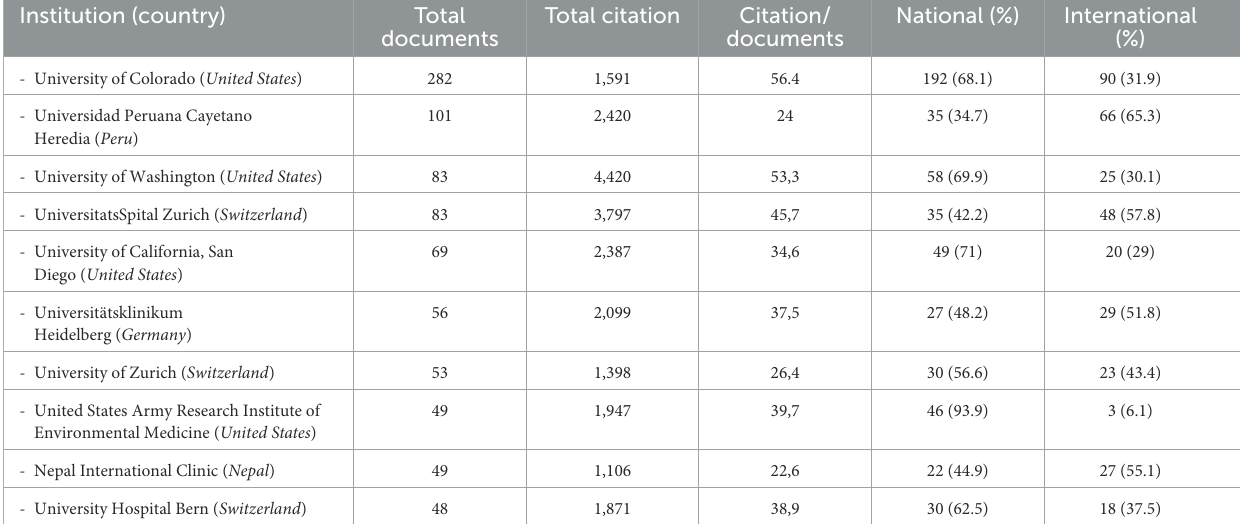
TABLE 3 Top 10 publications and institutional collaboration on adaptation and altitude illnesses in Scopus,